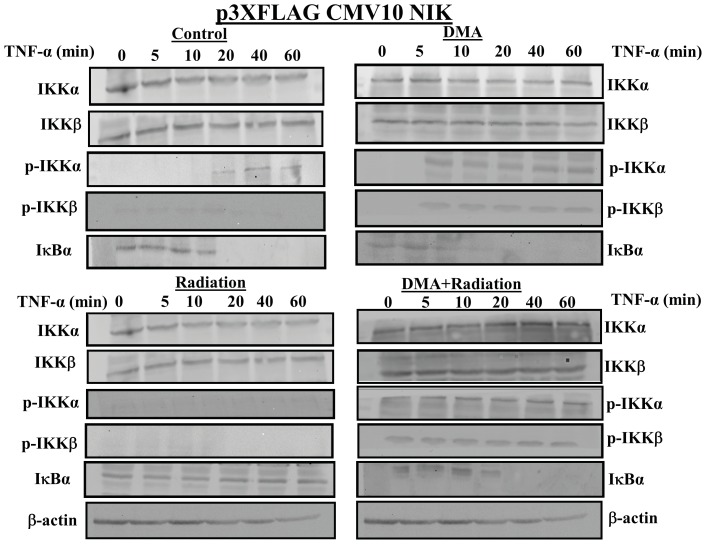
Effect of NFκB inducing kinase overexpression on the phosphorylation of IKKα and IKKβ.U87, human glioma cells were transiently transfected with p3XFLAG CMV10 NIK. Phosphorylation of IKKα, IKKβ was advanced in NIK overexpressing cells as compared to siRNA transfected cells in response to DMA treatment, alone or in combination with IR.